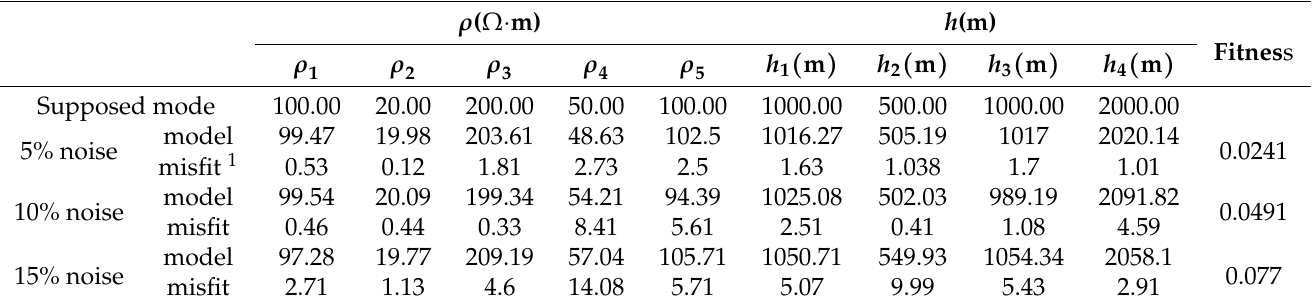
Figure 12. The predicted five-layer geoelectric models and their MT responses under noisy conditions. ( a – c ) represent the geoelectric model, apparent resistivity responses and phase responses, respectively. The blue lines represent the supposed three-layer electrical model and clean MT responses, and the purple lines represent the predicted geoelectric model and its MT responses when the noise level is 5%. The green lines represent the predicted geoelectric model and its MT responses when the noise level is 10%. The red lines represent the predicted geoelectric model and its MT responses when the noise level is 15%. Table 4. Comparison of the accuracy of the predicted five-layer geoelectric model under different noise